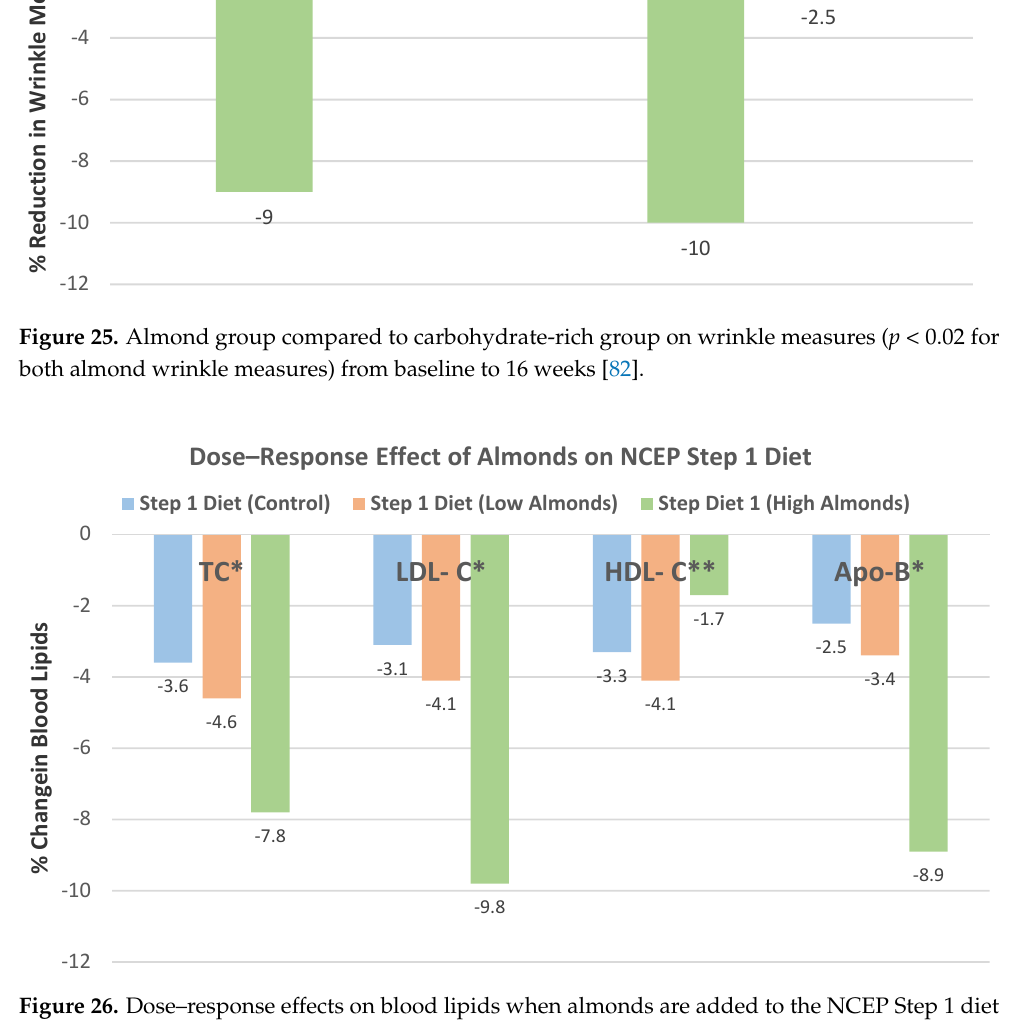
Figure 26. Dose–response effects on blood lipids when almonds are added to the NCEP Step 1 diet from baseline to 4 weeks: high almond intake significantly improved non-HDL-C lipids * ( p < 0.001) and insignificantly changed hDL-C ** ( p = 0.09)